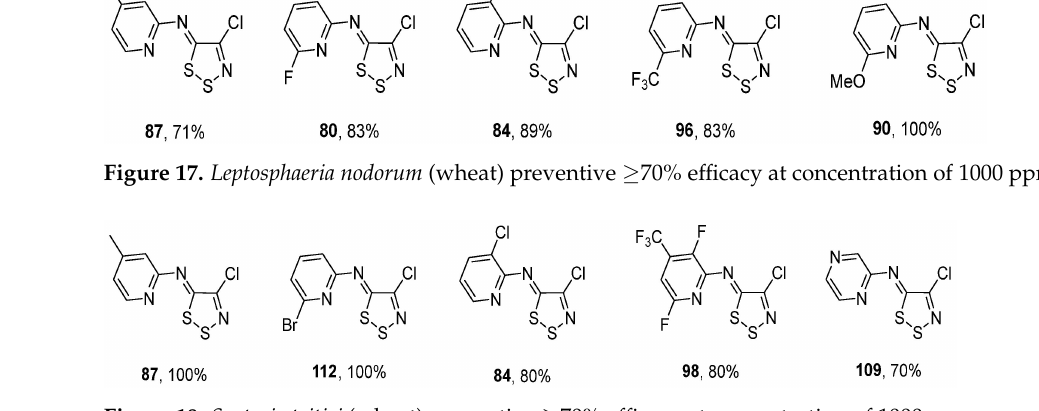
Figure 18. Septoria tritici (wheat) preventive ≥ 70% efficacy at concentration of 1000 ppm.